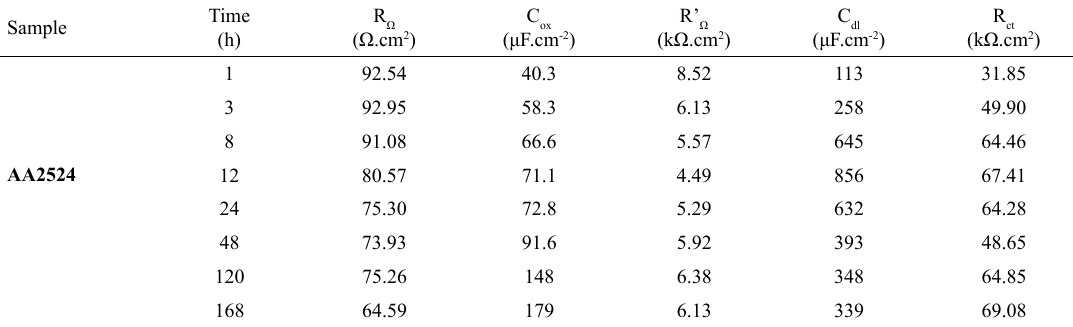
Table 2. Average values of the EIS parameters of AA2524-T3 aluminium alloy obtained by Zview 2 software. Sample